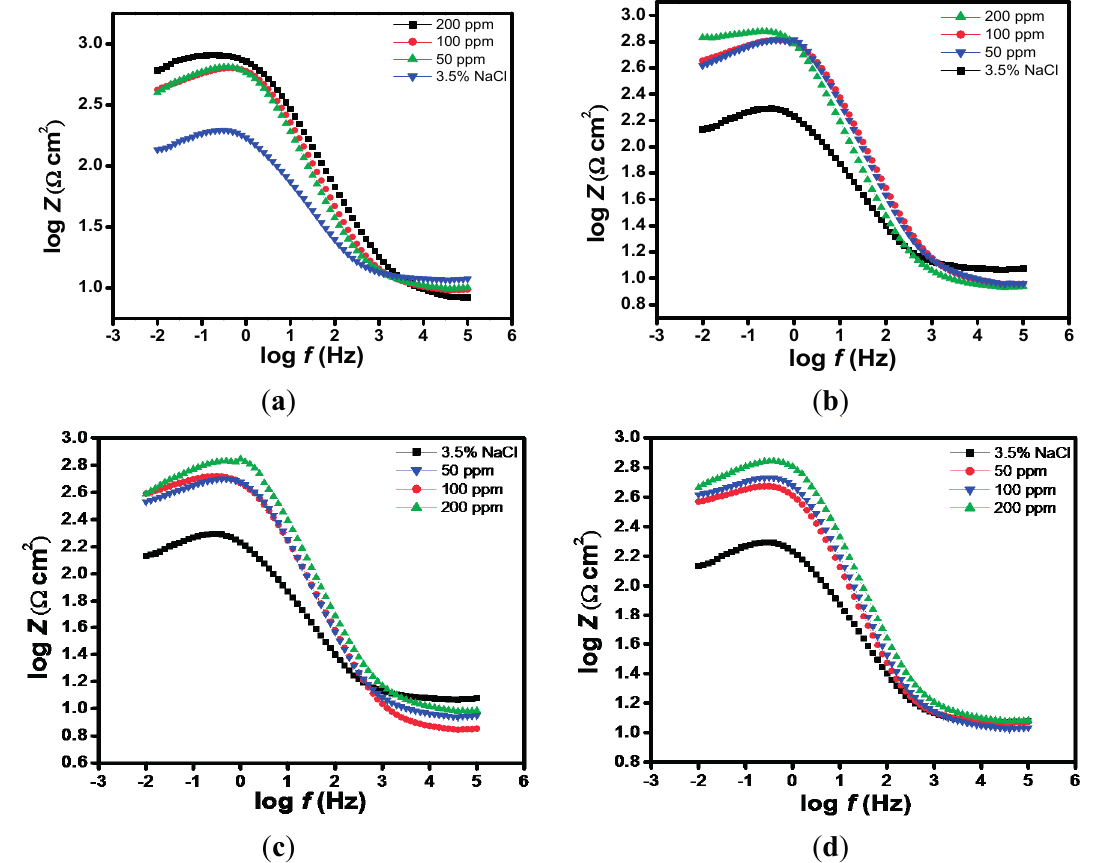
Figure 3. Bode modulus plots of N80 steel in 3.5% NaCl saturated with CO 2 without and with various concentrations of ( a ) HPTB; ( b ) T4PP; ( c ) THP and ( d )